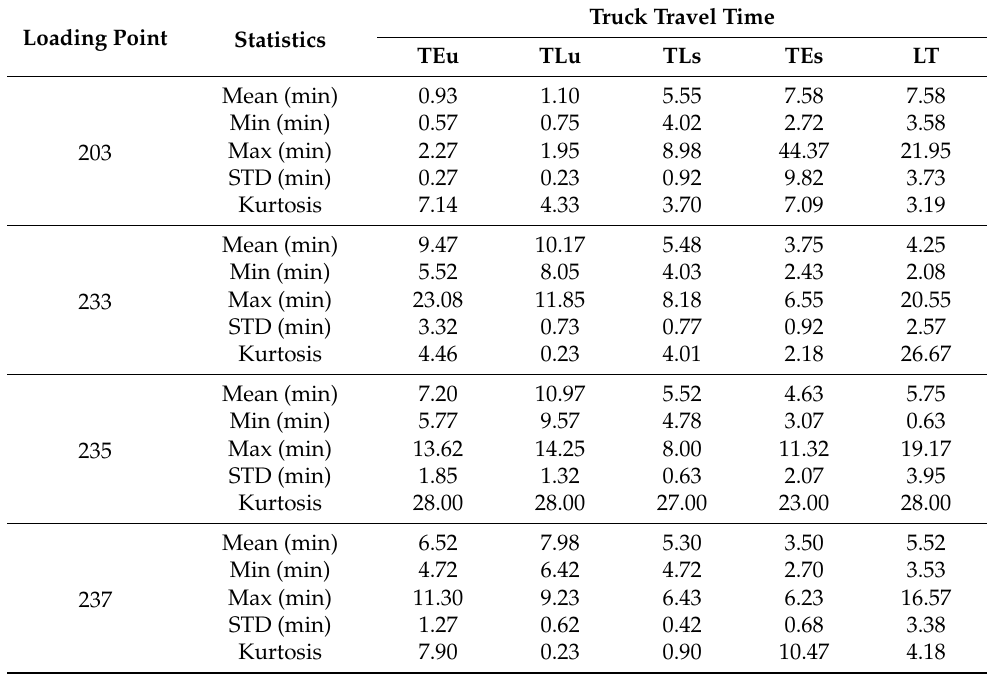
Table 4. Results of the statistical analysis of the truck travel time measured using the big